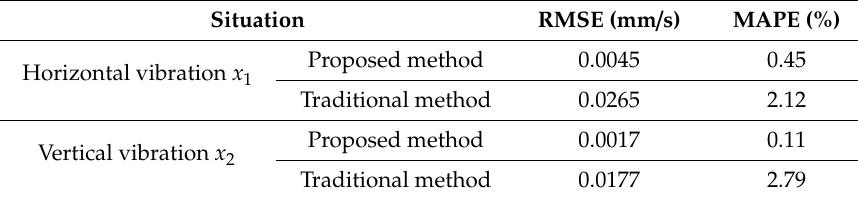
Table 4. Comparison of RMSE and MAPE for condition